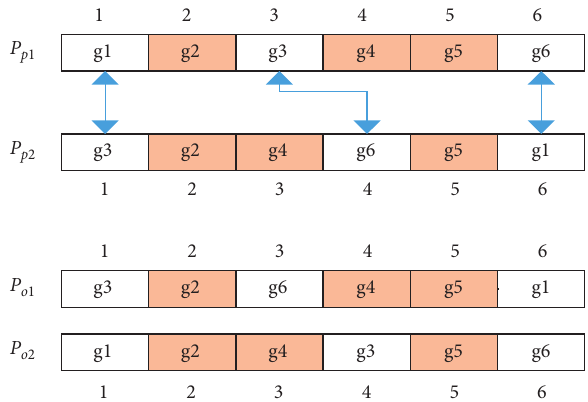
Figure 1: Schematic diagram of position-based crossover.